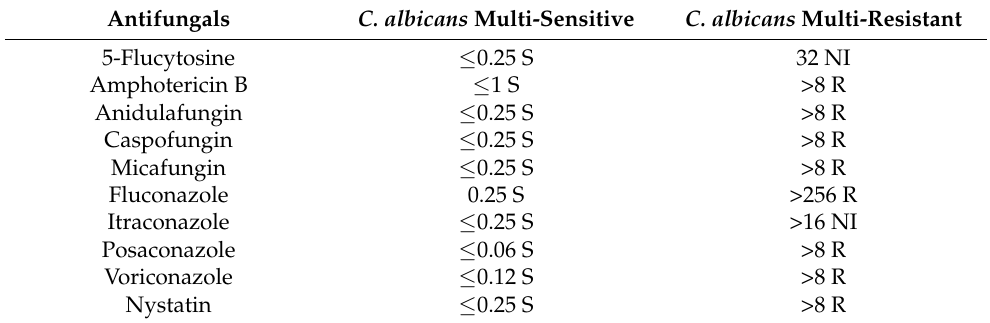
Table 2. Comparison between antimycogram performed before and after first treatment with flucona- zole and probiotics. Antifungals C. albicans Multi-Sensitive C. albicans Multi-Resistant 5-Flucytosine ≤ 0.25